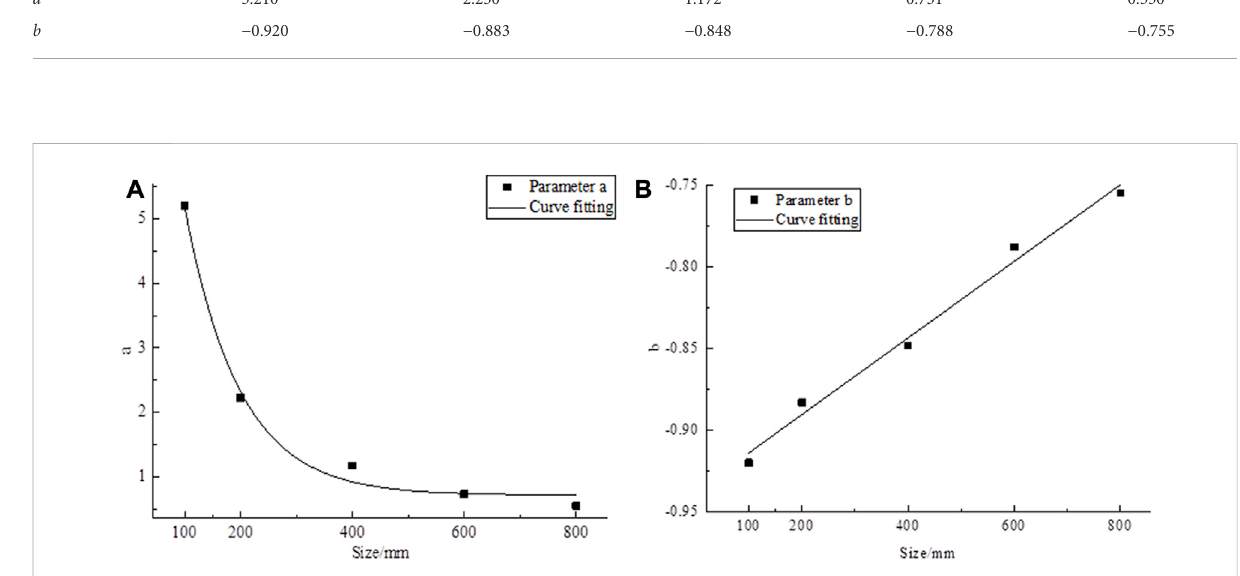
FIGURE 3 Fitting curve diagram of parameters: (A) parameter a and (B) parameter